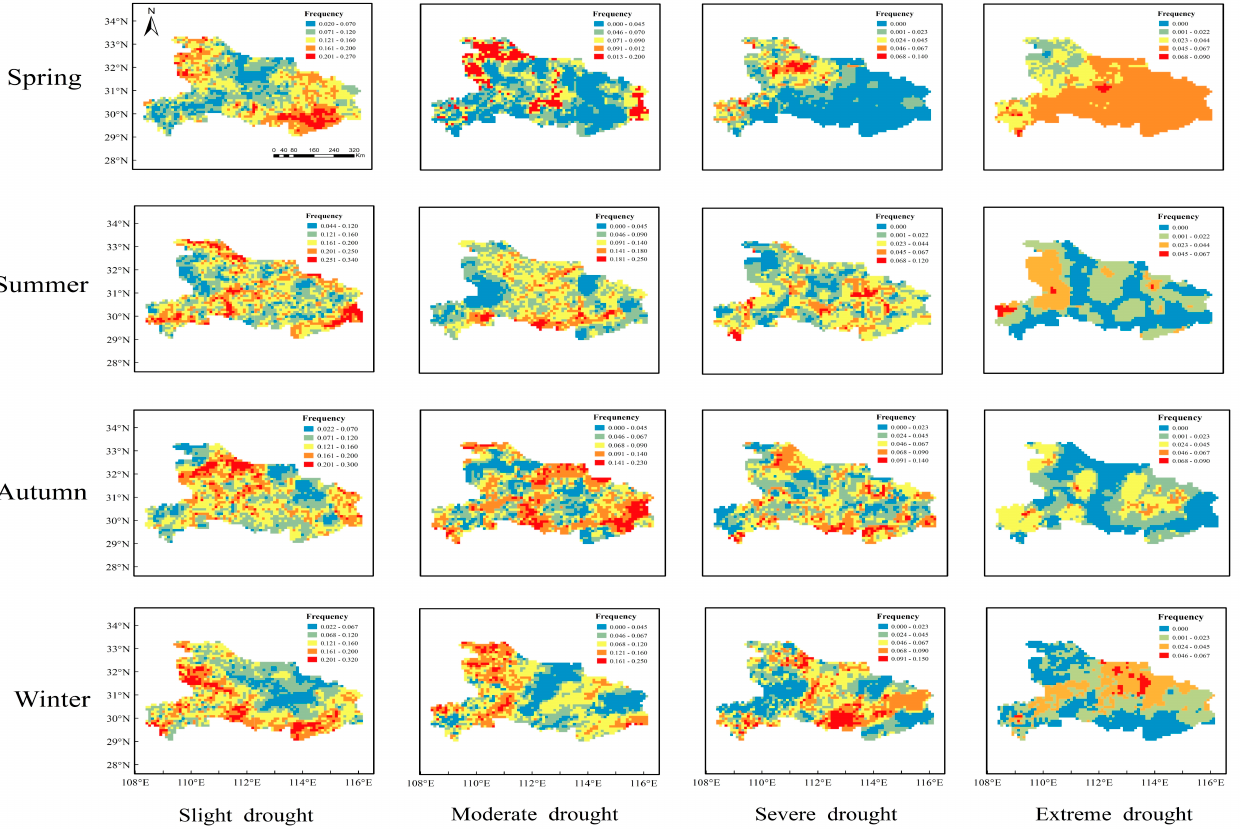
Figure 6. Seasonal drought frequency with different categories based on SPI-3. The results showed that the highest frequency of drought was most likely to occur in the summer in the northwest of Hubei Province, central Yichang, central Enshi, and southeast Huanggang. According to the distribution characteristics of droughts that occurred in different seasons, the average frequency of droughts was 27%, 33%, 31%, and 31% in spring, summer, autumn, and winter, respectively. In spring, the frequency of slight drought varied from 2% to 27%, mainly distributed in the northwest, Xianning, part of Jingzhou, and the southeast of Wuhan. The frequency of moderate and severe droughts was less than 20%, which were mainly distributed in the northwest and southwest regions, and there were few that occurred in the central region and Jianghan Plain. The extreme drought occurred only in the central region, and the maximum frequency was low at only 9%. In summer, drought affected more areas than spring drought, and it mainly occurred in the whole Hubei province with the category of slight drought, moderate drought, and severe drought, and the maximum frequency of slight drought was up to 34%. In autumn, the distribution characteristics of drought were similar to that in summer; conversely, the frequency of slight and moderate drought decreased with the maximum frequency being 30% and 23%, respectively, while the frequency of severe and extreme drought slightly increased. In winter, the distribution characteristics of drought were more distinct than other seasons since slight drought was mainly distributed in the west, southwest, and southeast; moderate drought was intensively concentrated in the western plateau, and severe and extreme drought was mainly distributed in the central part of Hubei